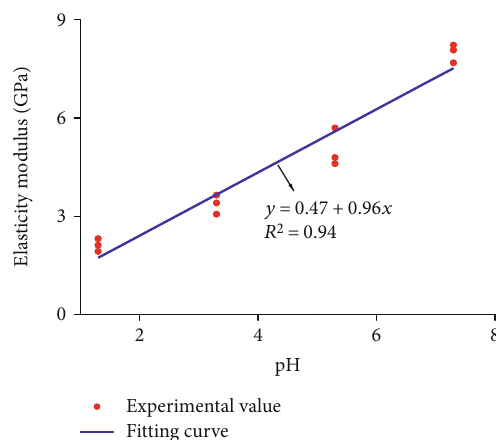
Figure 6: Variation trend of elastic modulus with pH.